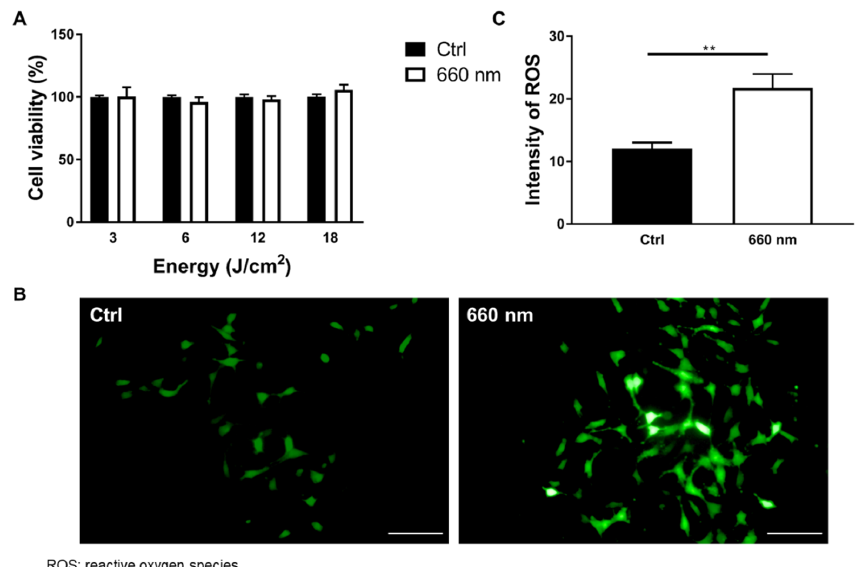
Figure 3. Alteration of Cell Viability and ROS Expression Induced by 660-nanometer LED Irradiation. ( A ) Cell viability (%) analyses after 24 h of 660-nanometer LED irradiation with a power of 10 mW/cm 2 and various total energies (3, 6, 12 and 18 J/cm 2 ). Results showed that there were no significant effects on overall cell types at any power density ( p > 0.05; n = 9); ( B ) Representative images of the ROS assay (FITC) (scale bar: 100 µ m); ( C ) The intensity of ROS-positive (FITC+) cells was significantly increased by LED irradiation (Ctrl vs. 660 nm; n = 48 vs. 57, ** p < 0.01).